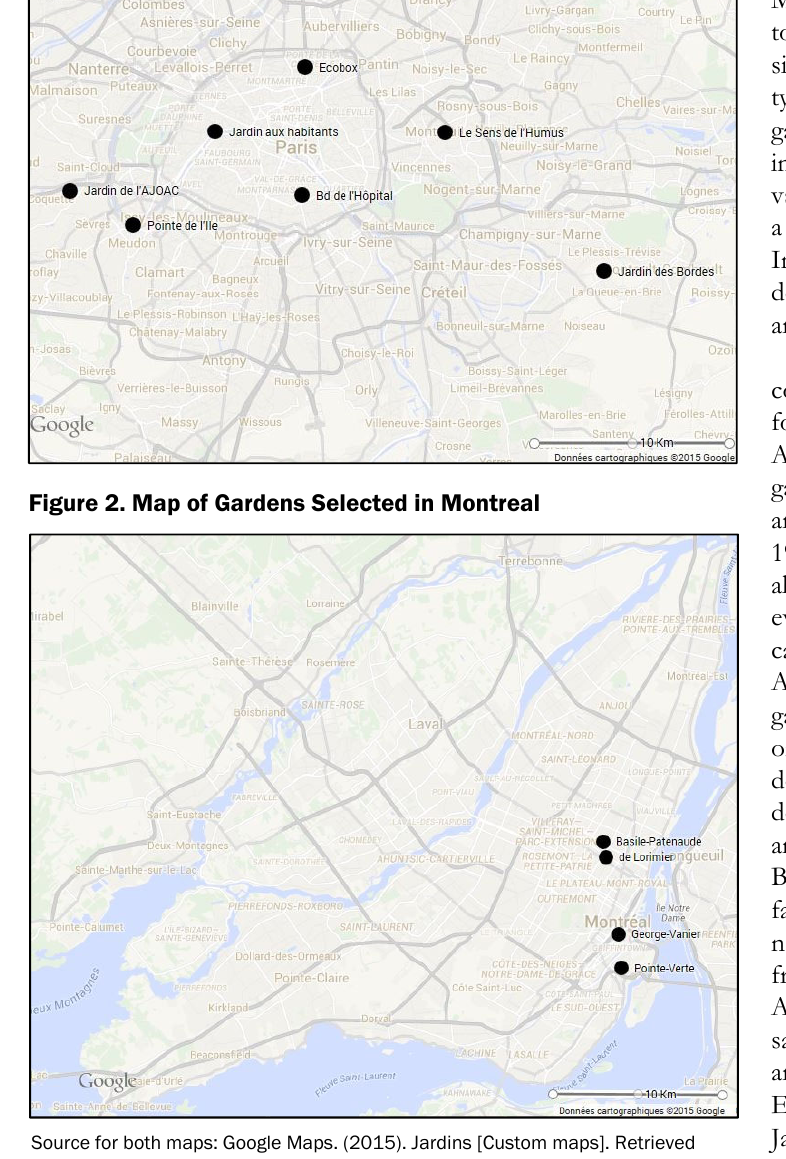
Source for both maps: Google Maps. (2015). Jardins [Custom maps]. Retrieved from